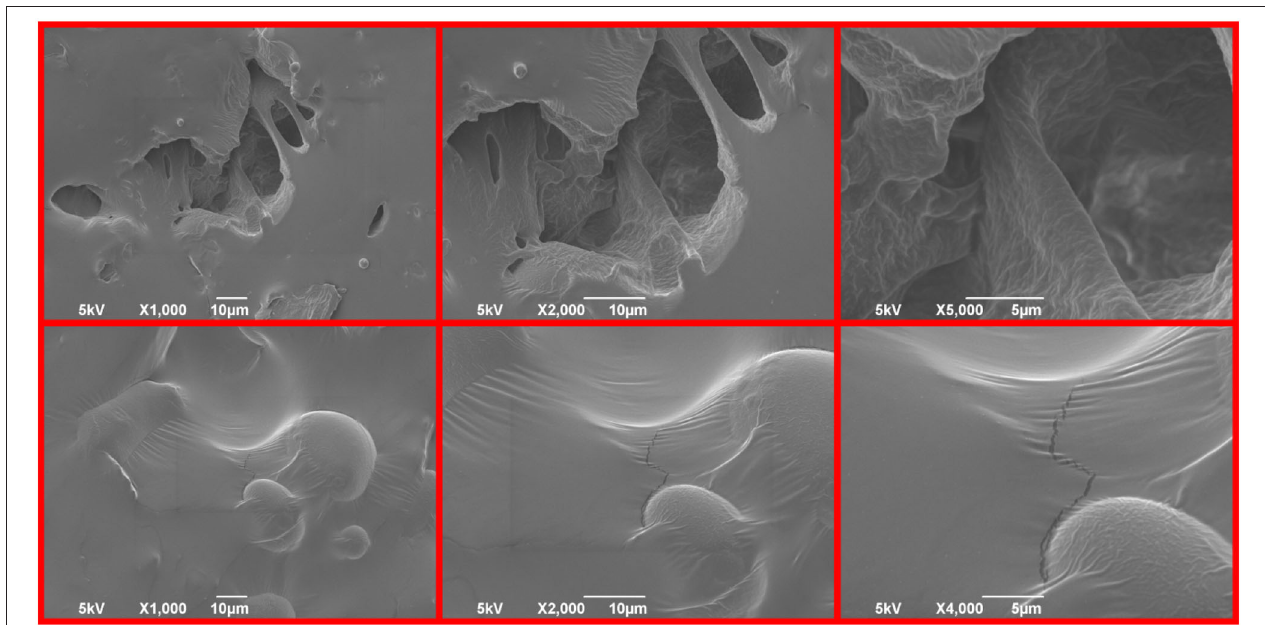
FIGURE 4 | Sample E43PS50W. Observed cracks and caves ascribable to the degradation of the material in the